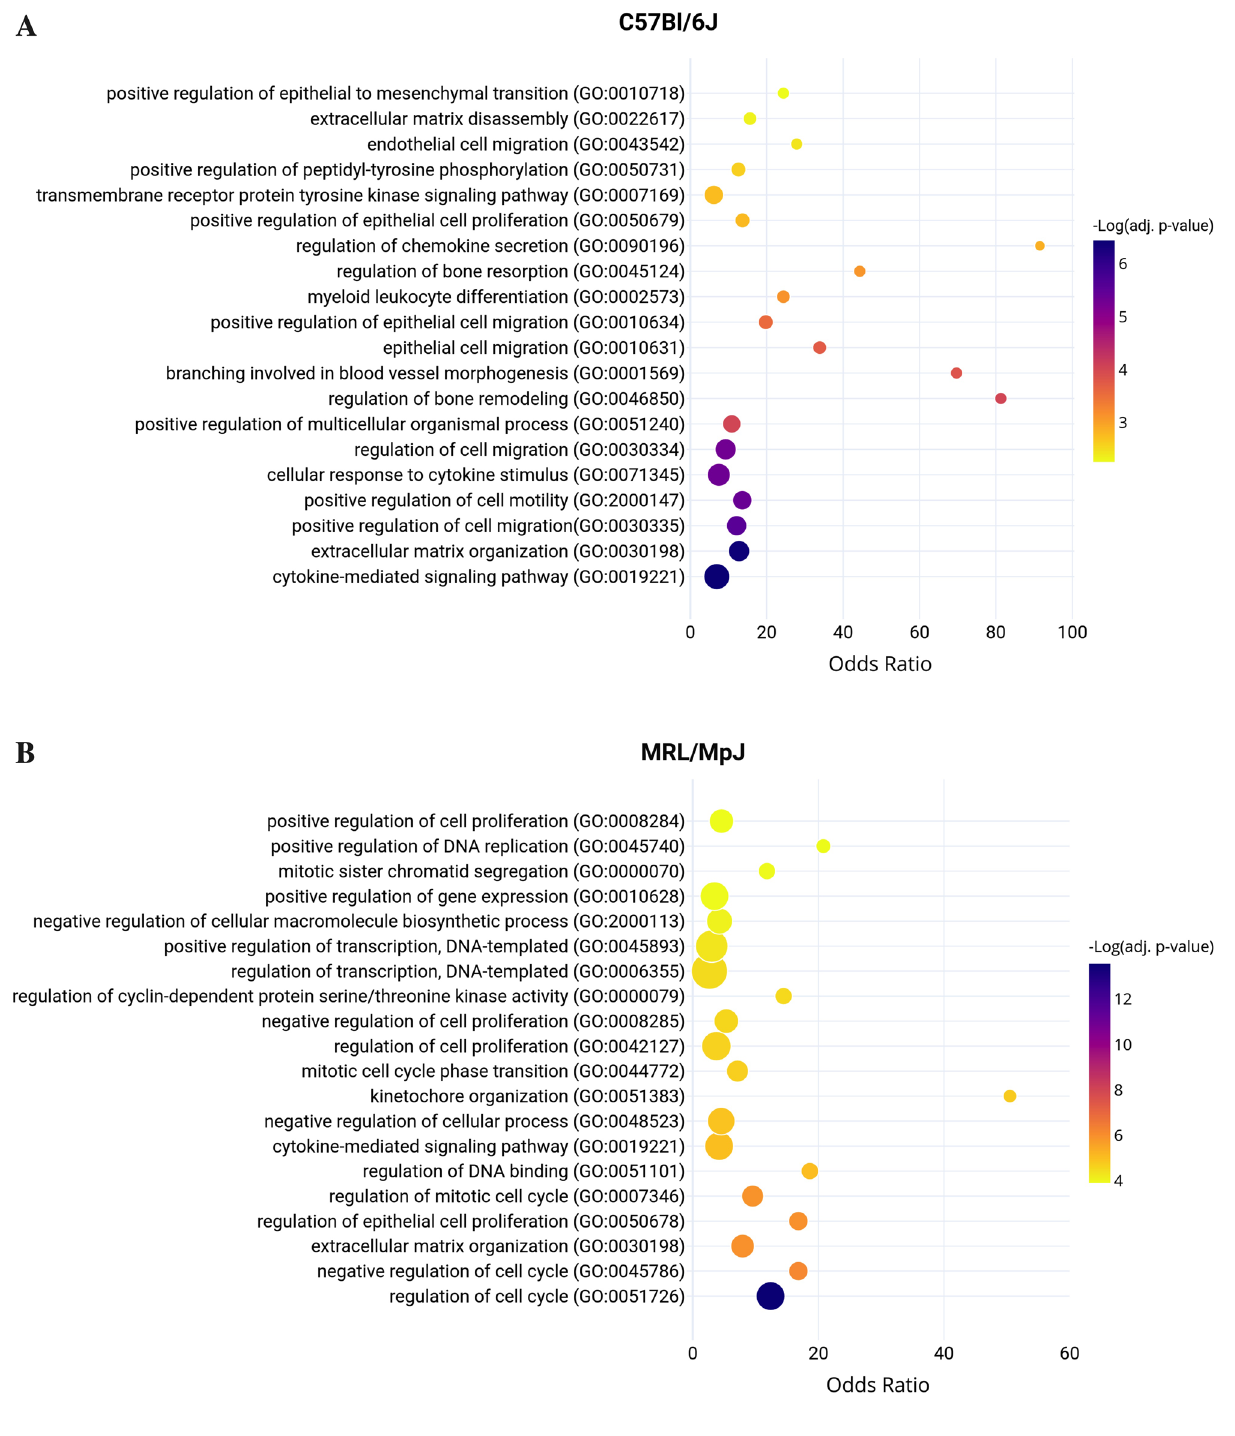
Figure 8. Biological Process Gene Ontology (GO) of 76 genes contributing to the activation of TGFB1 Upstream Regulator in the healing C57 tendon ( A ). Biological Process Gene Ontology (GO) of 160 genes contributing to the activation of TGFB1 Upstream Regulator in the healing MRL tendon ( B ). Bubble area corresponds to the number of genes in the enriched GO biological